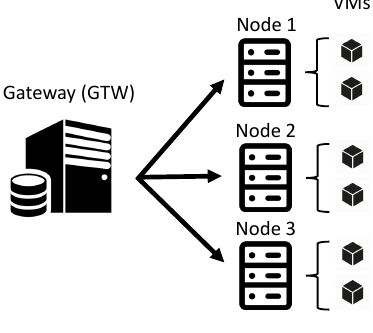
Figure 8. Case-study in